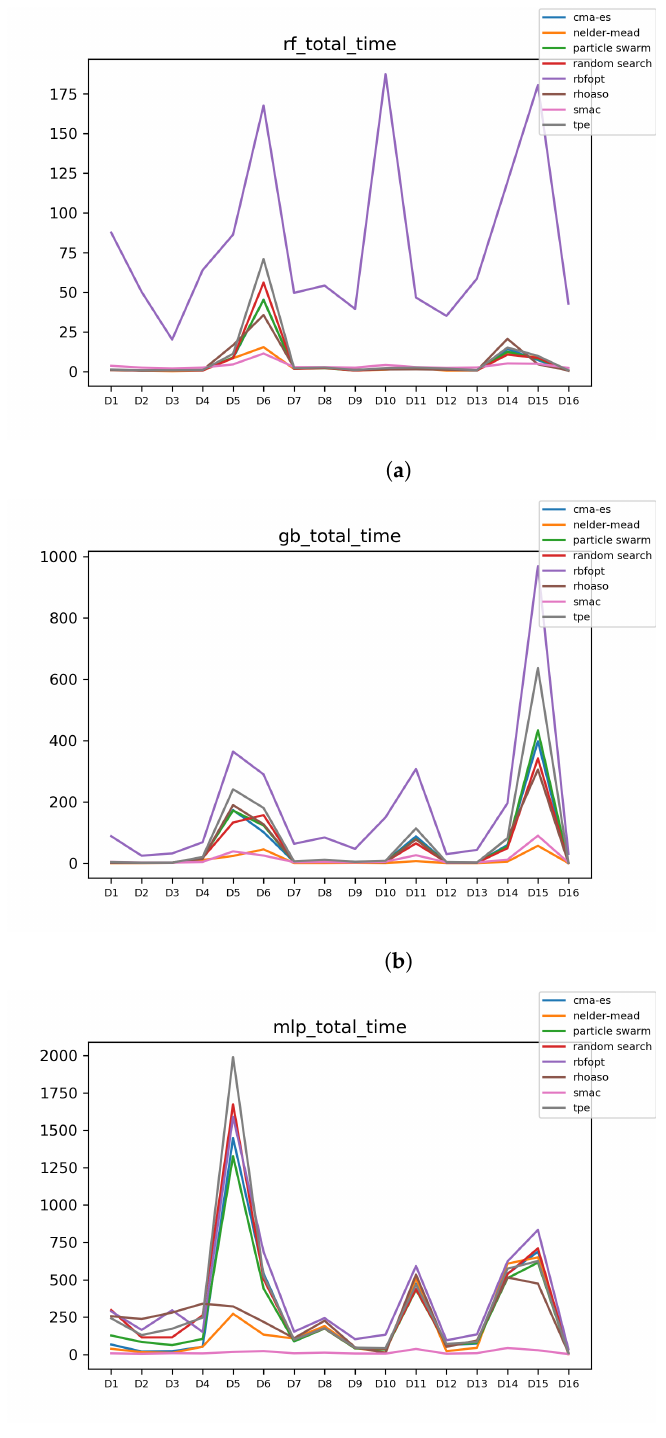
Figure 14. Experiment 2: Time complexity. ( a ) Time complexity in RF. In axis X, the dataset. In axis Y, the total time obtained measured in seconds. Each line represents a HPO algorithm. ( b ) Time complexity in GB. In axis X, the dataset. In axis Y, the total time obtained measured in seconds. Each line represents a HPO algorithm. ( c ) Time complexity in MLP. In axis X, the dataset. In axis Y, the total time obtained measured in seconds. Each line represents a HPO